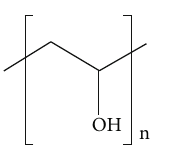
Figure 61: Chemical structure of